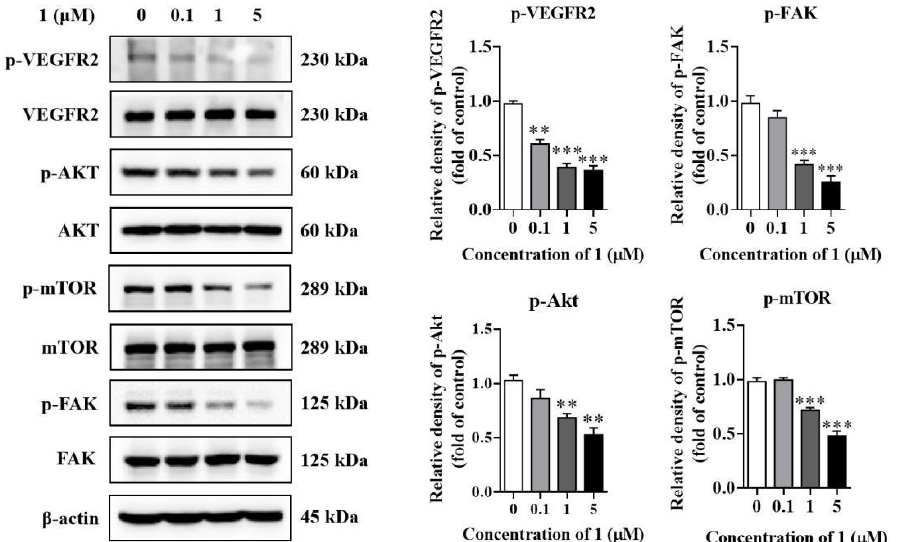
Figure 6. The effects of 1 on protein expression and phosphorylation levels of VEGFR2 and its downstream signaling pathways in breast cancer cells. The levels of p-VEGFR2, VEGFR2, p-Akt, Akt, p-mTOR, mTOR, p-FAK and FAK were determined by Western blots. ( n = 3, means ± SEM are shown, ** p < 0.01, *** p < 0.001, compared with control).